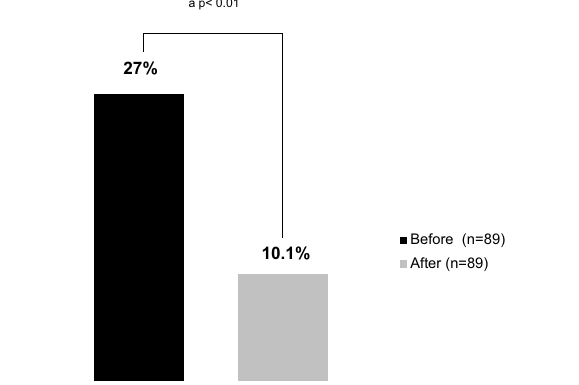
Figure 4. Institutional protocol “non-compliance” rate.